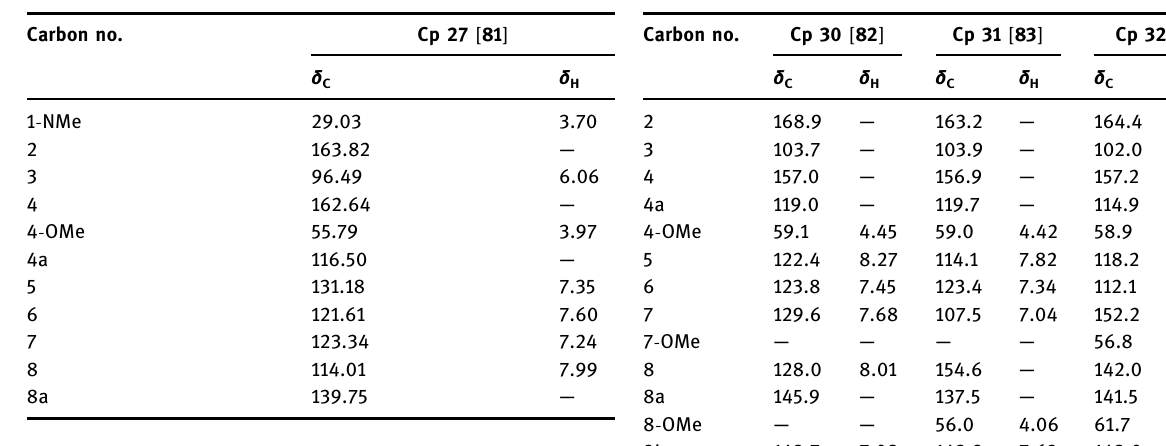
Table 10: 13 C and 1 H NMR chemical shift data ( δ , ppm )